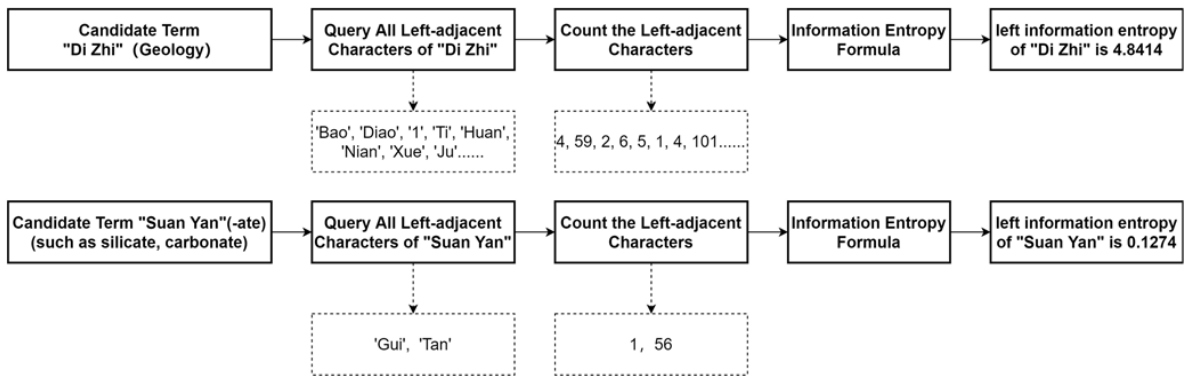
Figure 2. Flow chart of information entropy calculation.